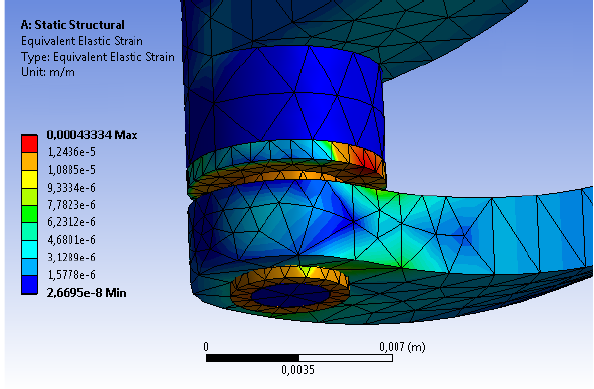
Figure 4. Modeling of the bushings: plot of the equivalent elastic strain on the deformed configuration (scale 100 ×